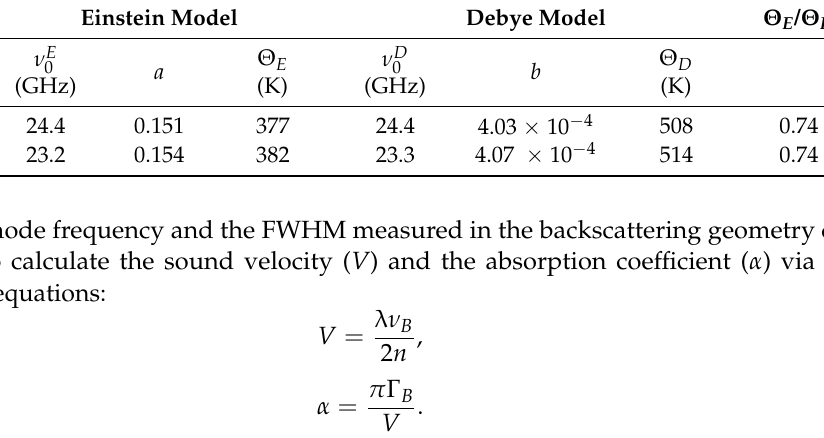
Table 1. The best-fitted results for the LA modes by using two models as described in the text. Einstein Model Debye